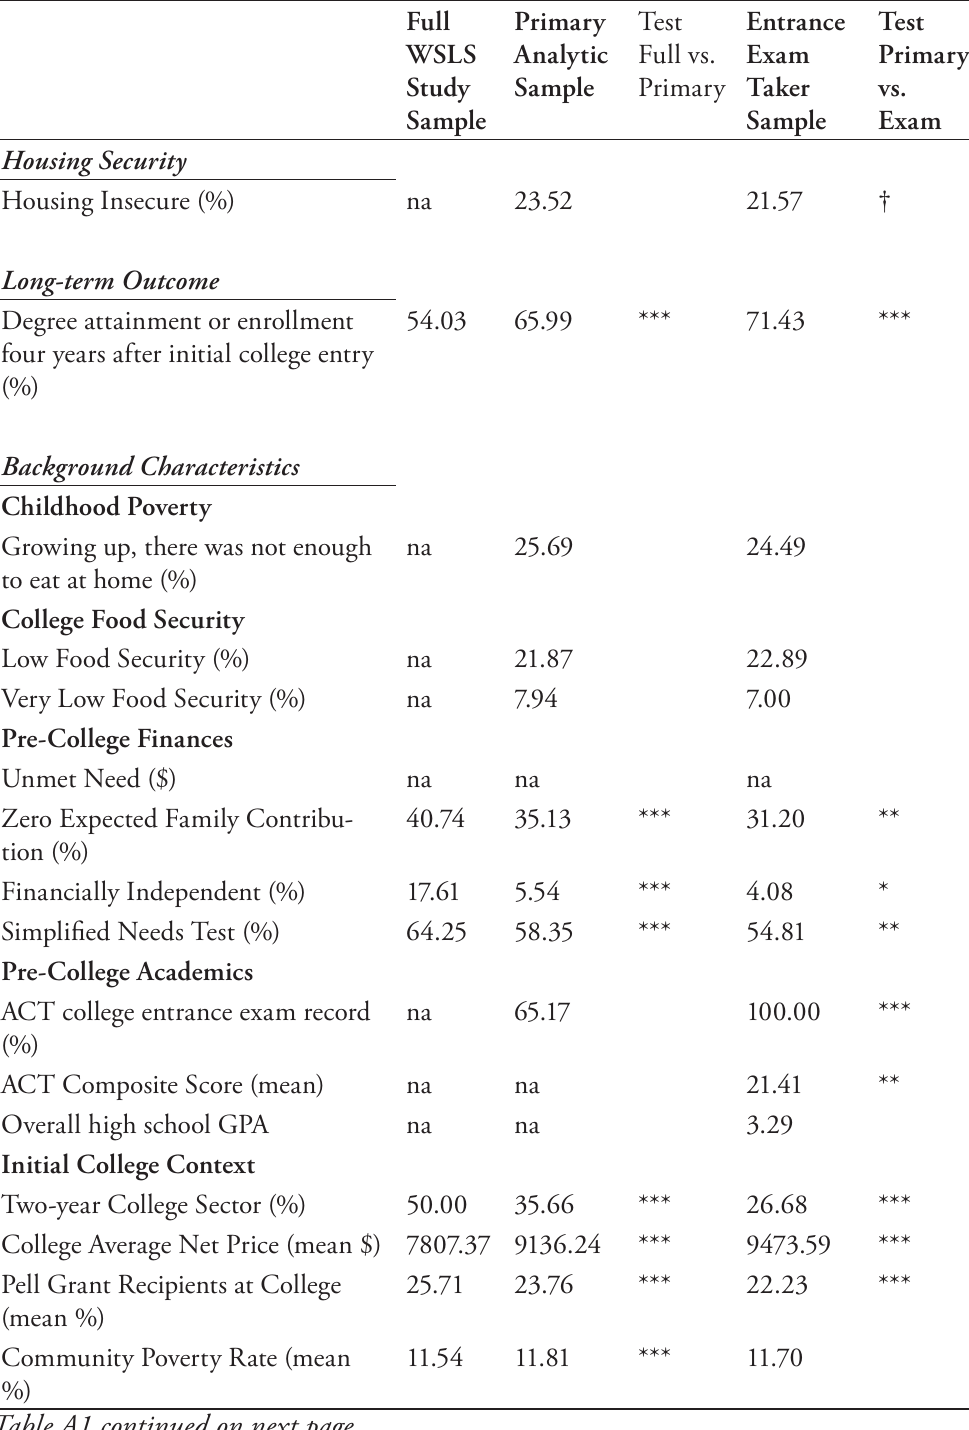
Table A1: Sample characteristics and tests of external validity